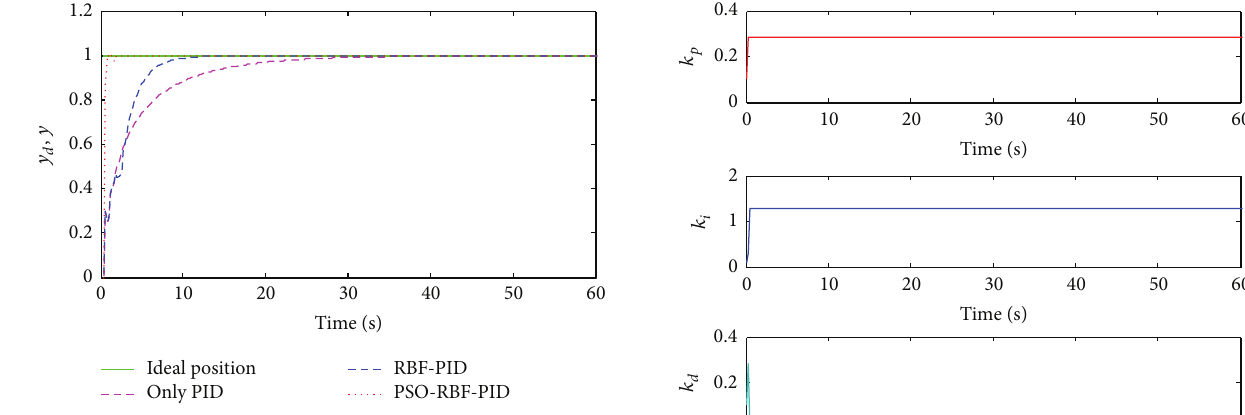
Figure 4: The step response of three kinds of algorithms.